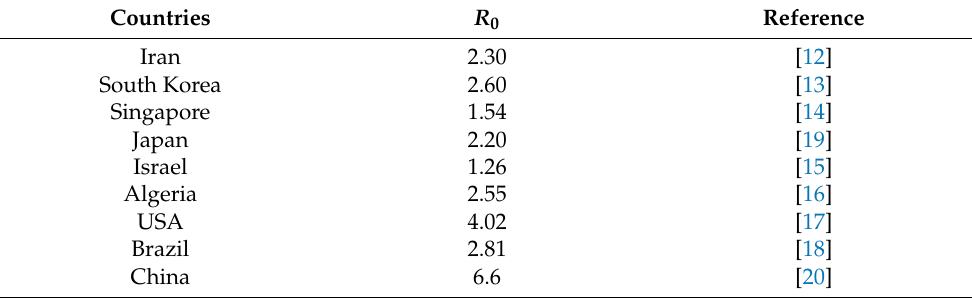
Table 1. The value of R 0 for selected